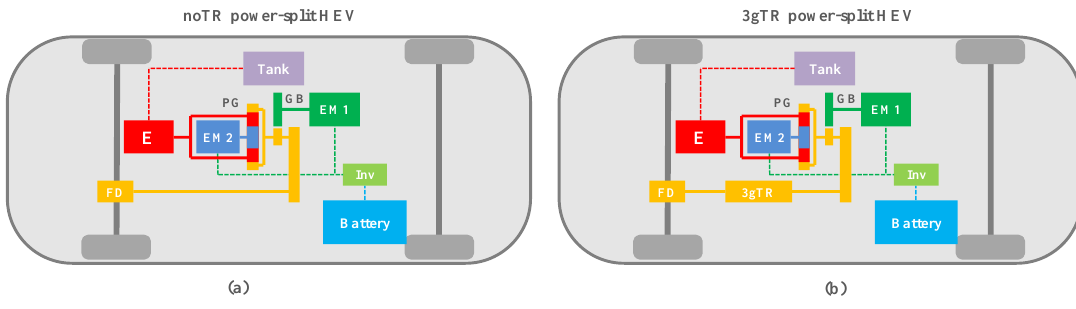
Figure 1. Scheme of the noTR ( a ) and 3gTR ( b ) power-split layouts considered in this study.